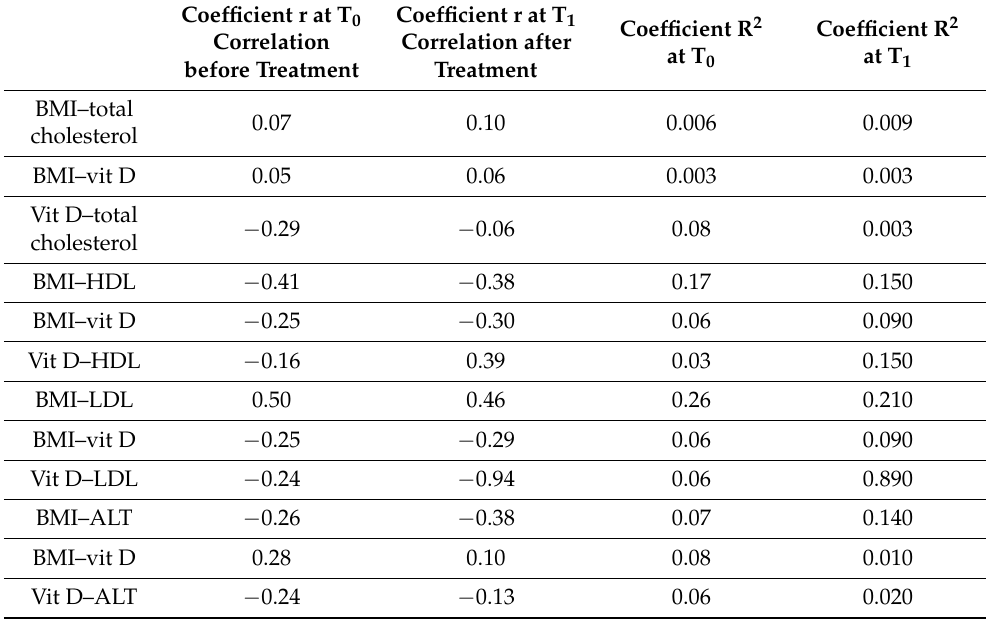
Table 2. Correlation coefficients (r, R2) between anthropometric and laboratory variables before and after vitamin D supplementation in patients with an increase in serum 25(OH)D after vitamin D supplementation.